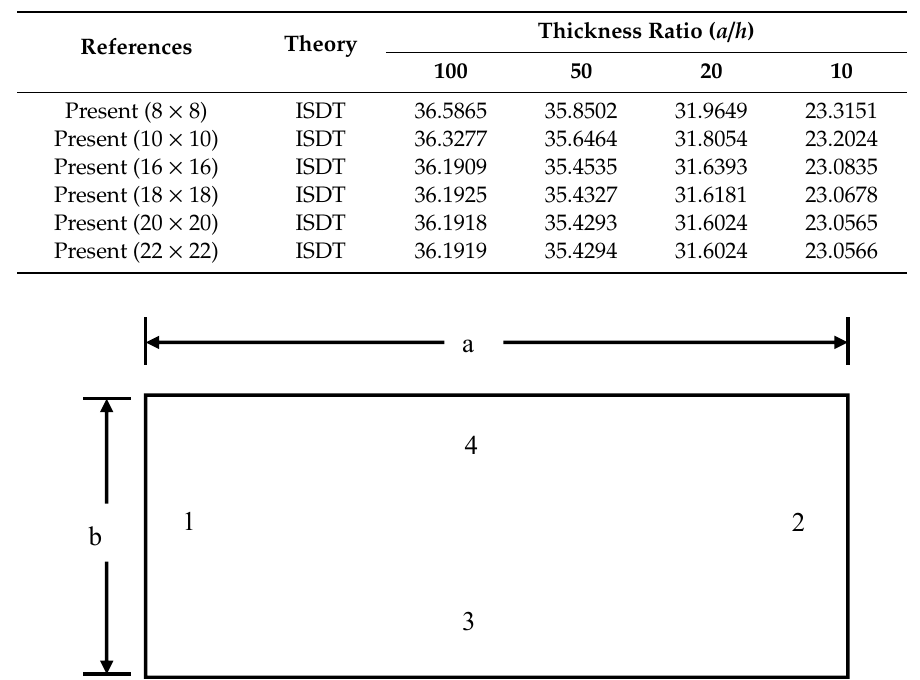
Figure 2. Numbering of edges of the plate.